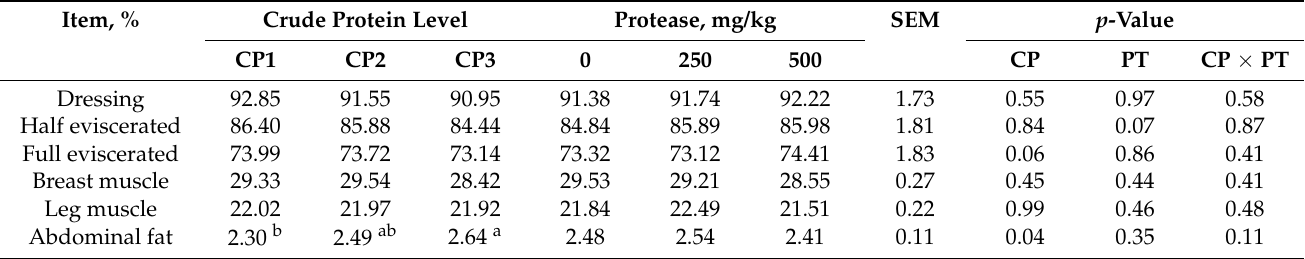
Table 4. Effects of dietary crude protein and protease levels on carcass traits of broilers.